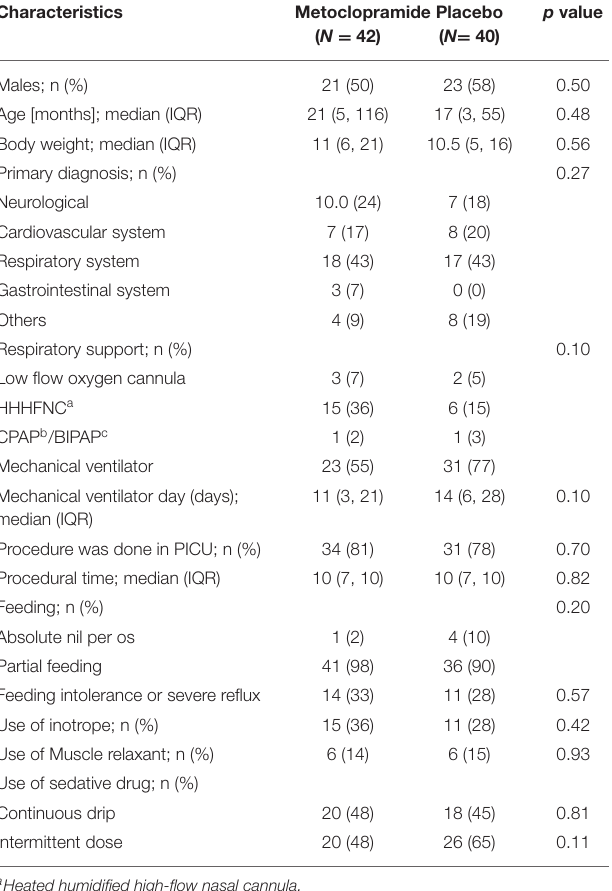
TABLE 3 | Success rate of post-pyloric feeding tube placement compared TABLE 1 | Demographic and clinical characteristics of the metoclopramide and between the metoclopramide and the placebo groups. the placebo groups. Characteristics Metoclopramide Feeding tube position Metoclopramide ( N = 42) ( n = 42)